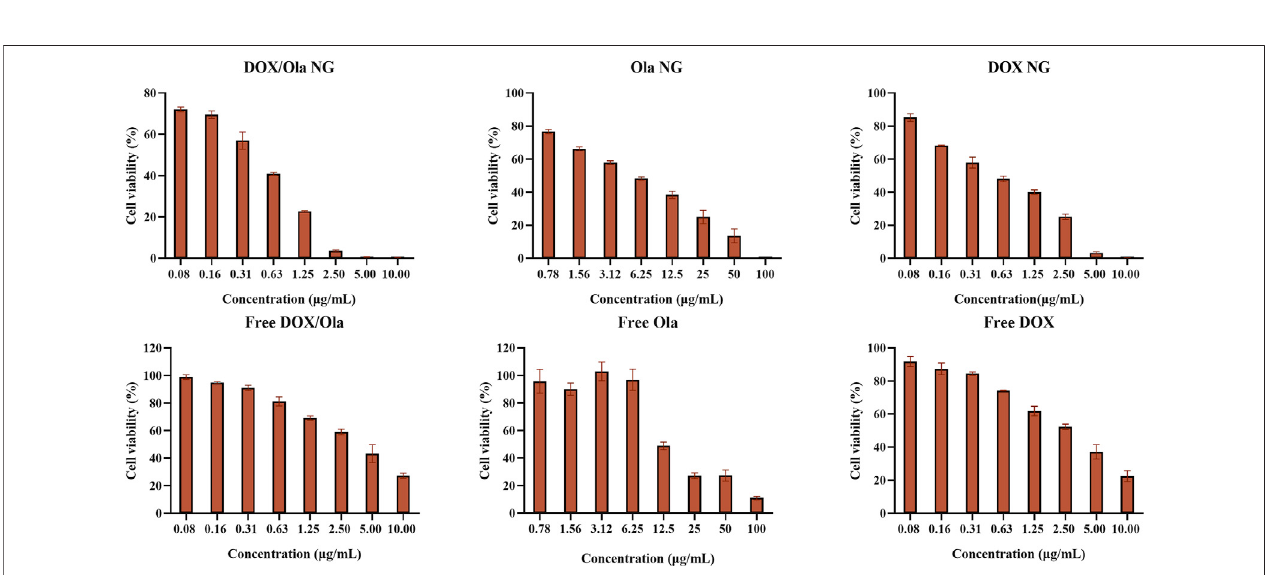
FIGURE 4 | Cytotoxicity experiment. The in vitro cytotoxicity of nanogels after incubation with 4T1 cells for 48 h. The statistical data are presented asa mean ± SD ( n = 3).